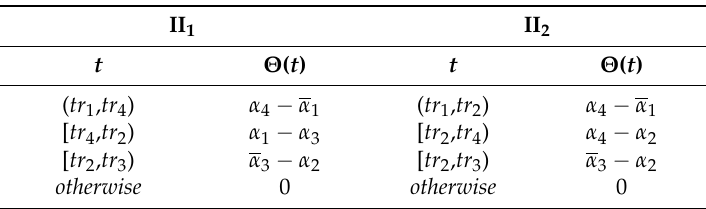
Table 3. Central angle summation of the intersected arc for projection points located in sub-regions II 1 and II 2 .